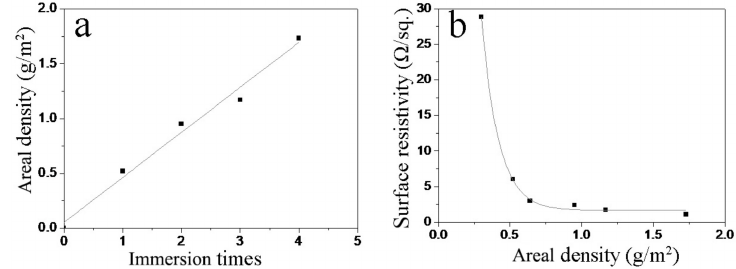
Figure 4. ( a ) Areal density of AgNWs versus immersion times in AgNWs slurry of paper; ( b ) Surface resistivity of paper versus areal density of AgNWs.